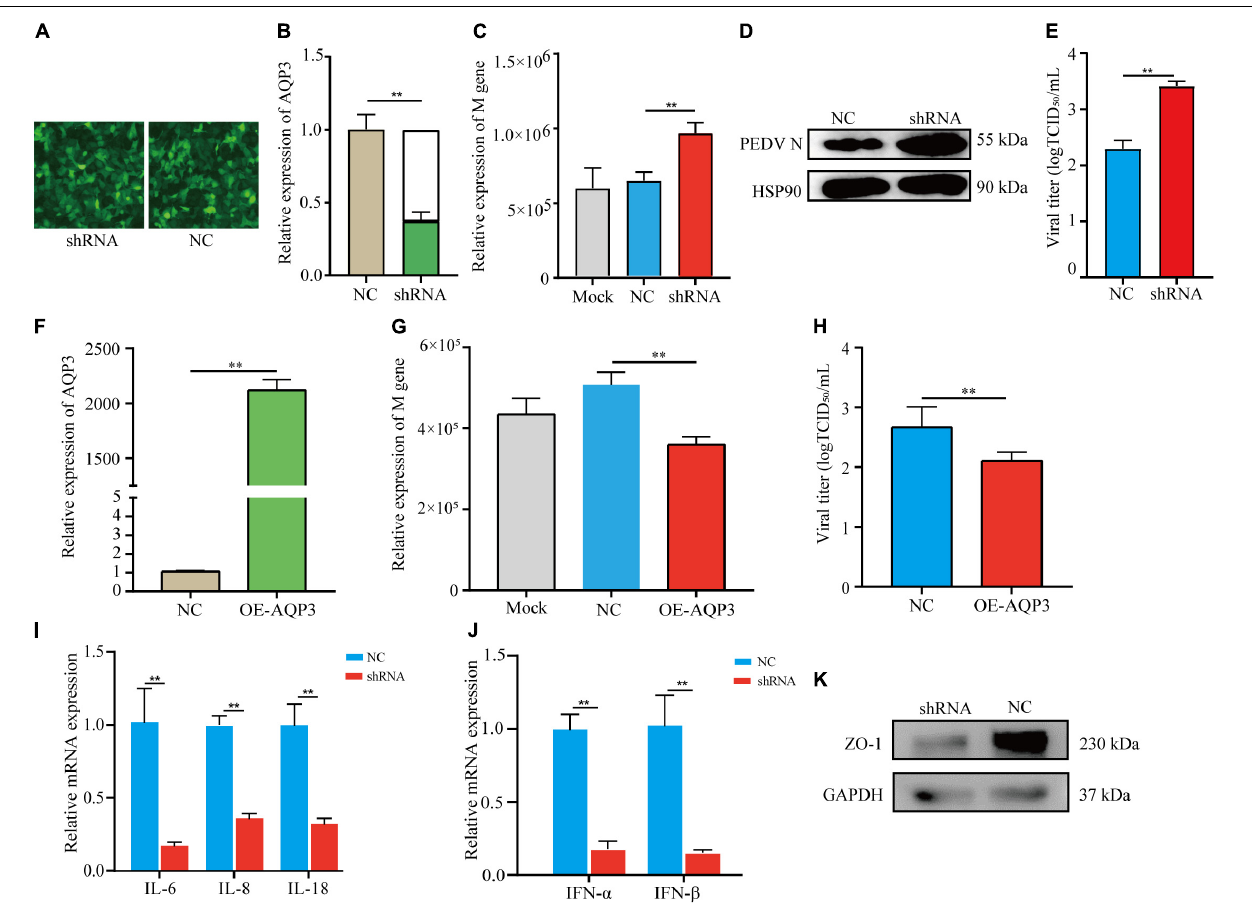
FIGURE 5 | Analysis of AQP3 function in mediating PEDV infection. (A) Fluorescence image of cell transfected with plasmids interfering AQP3 expression. shRNA, cells transfected with plasmids containing interfering sequence targeting AQP3; NC, cells transfected with plasmids containing scramble sequence. (B) Relative expression of the AQP3 gene. shRNA, AQP3 knockdown cells; NC, cells transfected with scramble sequence. (C) Relative expression of PEDV M gene. Mock, cells without plasmid transfection; shRNA, AQP3 knockdown cells; NC, cells transfected with scramble sequence. (D) Western blotting analysis of PEDV N protein after 24 h of PEDV infection. shRNA, AQP3 knockdown cells; NC, cells transfected with scramble sequence. (E) Effects of AQP3 knockdown on viral titers determined by measuring TCID50. NC, cells transfected with scramble sequence; shRNA, AQP3 knockdown cells. (F) Quantification of AQP3 expression level in